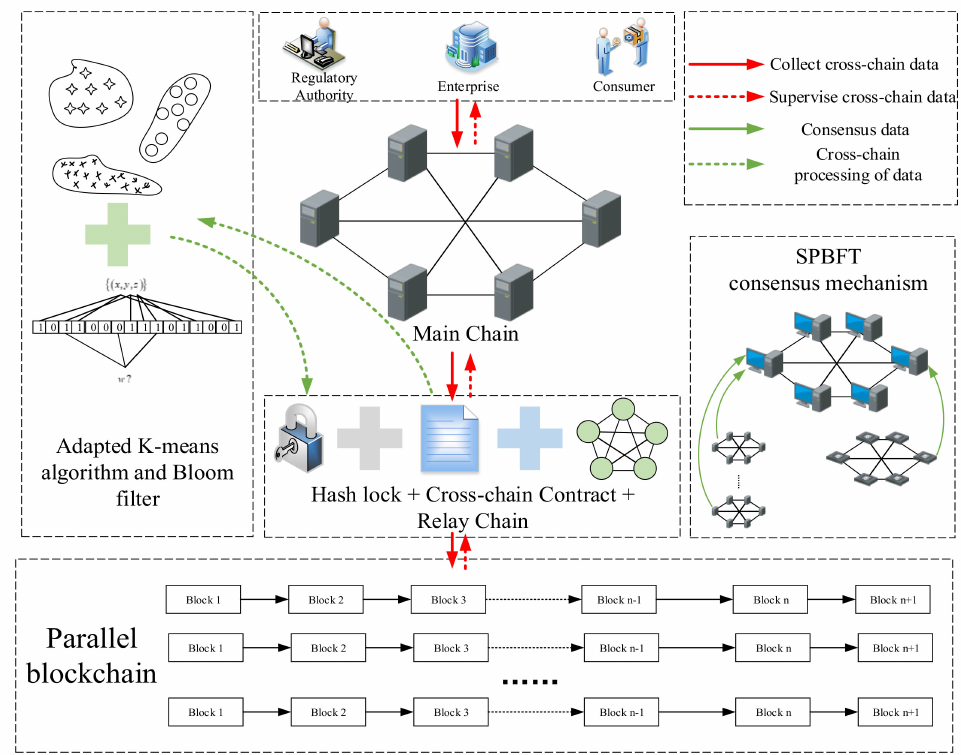
Figure 2. The cross-chain framework of rice supply chain